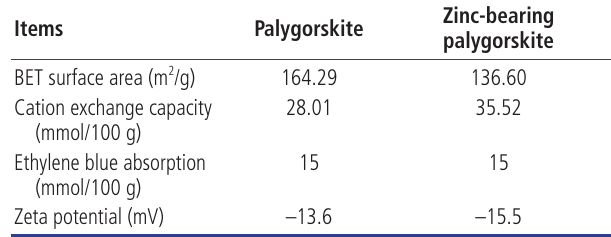
Table 2. Physico-chemical properties of the